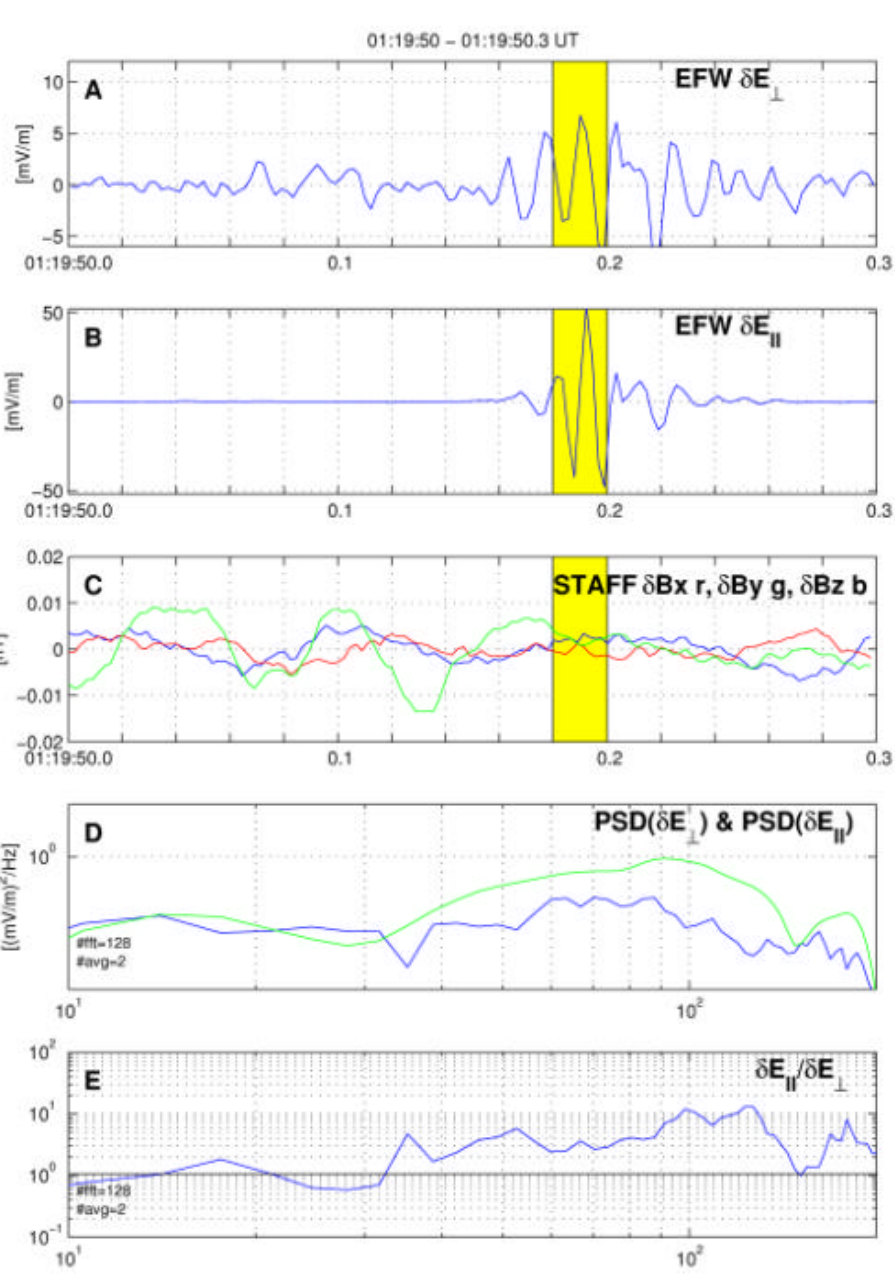
Fig. 5. Data from Cluster spacecraft 2 during part of the interval in Fig. 1; the panels are similar to Fig. 3. A wave burst with large parallel electric fields is observed. The interval indicated in yellow is studied in detail in Fig.